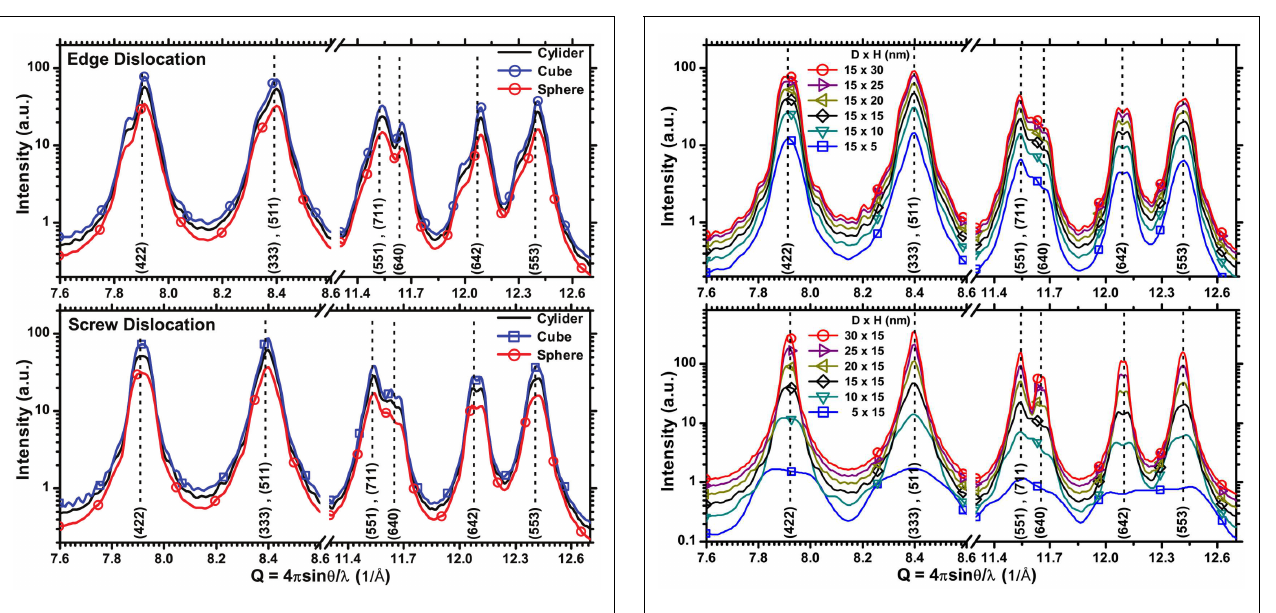
FIGURE 8 | X-ray powder diffraction patterns simulated by DSE from theTAM of Pd nanocrystals containing edge (upper plot) and screw (lower plot) dislocation lines, with different shapes: cylinder (black), cube (blue square dot), and sphere (red circular dot) .